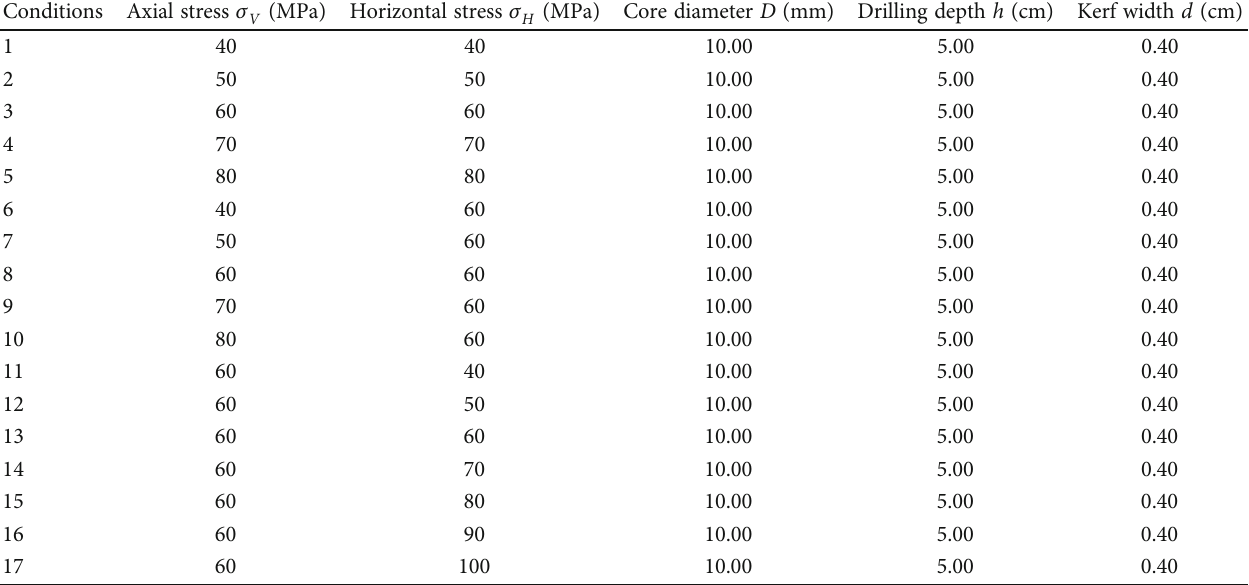
Table 2: Di ff erent in situ stress combination